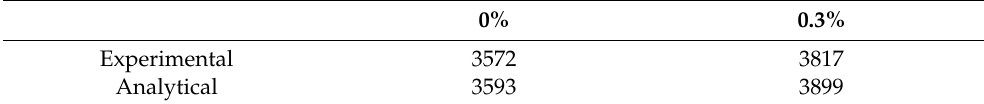
Table 4. Comparisons of critical loads for clamped–clamped CNTRC beams.